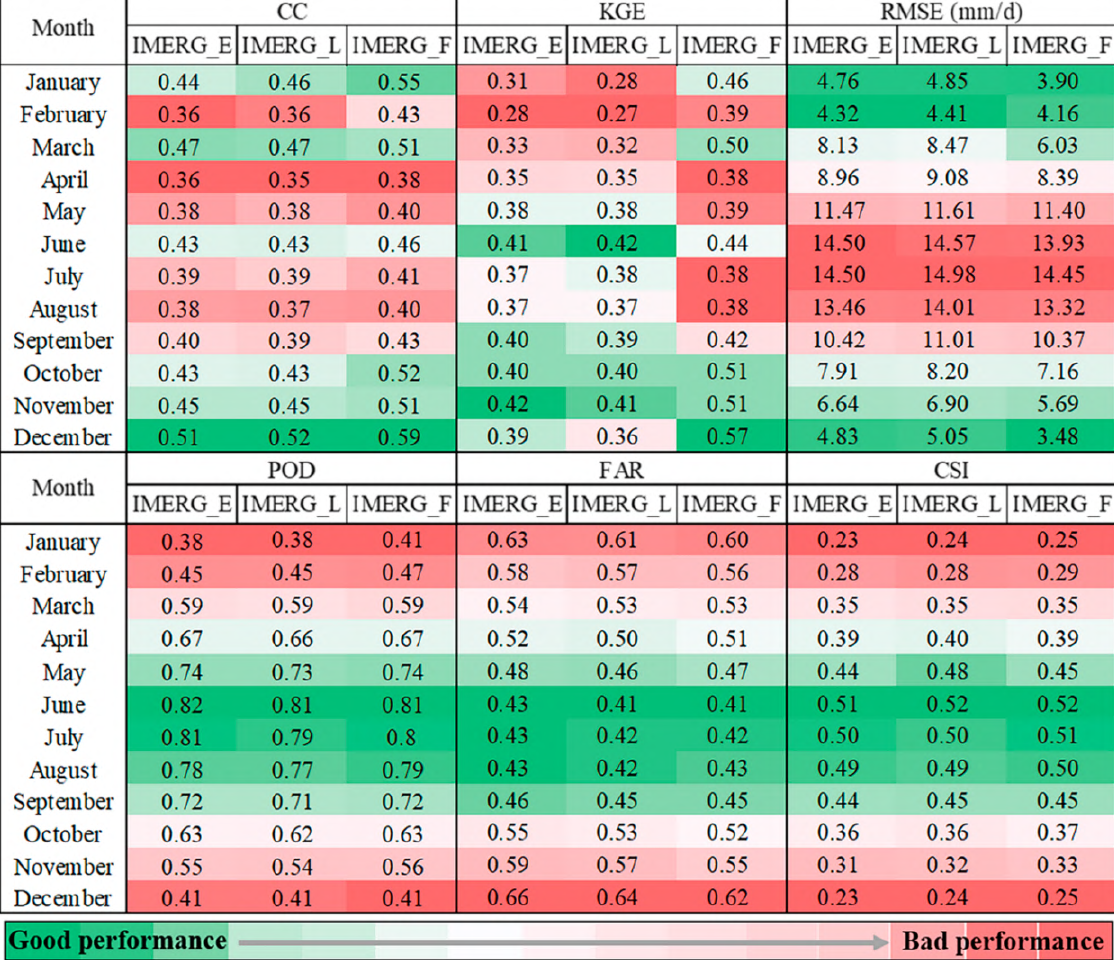
Figure 5. Accuracy comparison of IMERG_E, IMERG_L and IMERG_F products in each month during 2008–2017 across